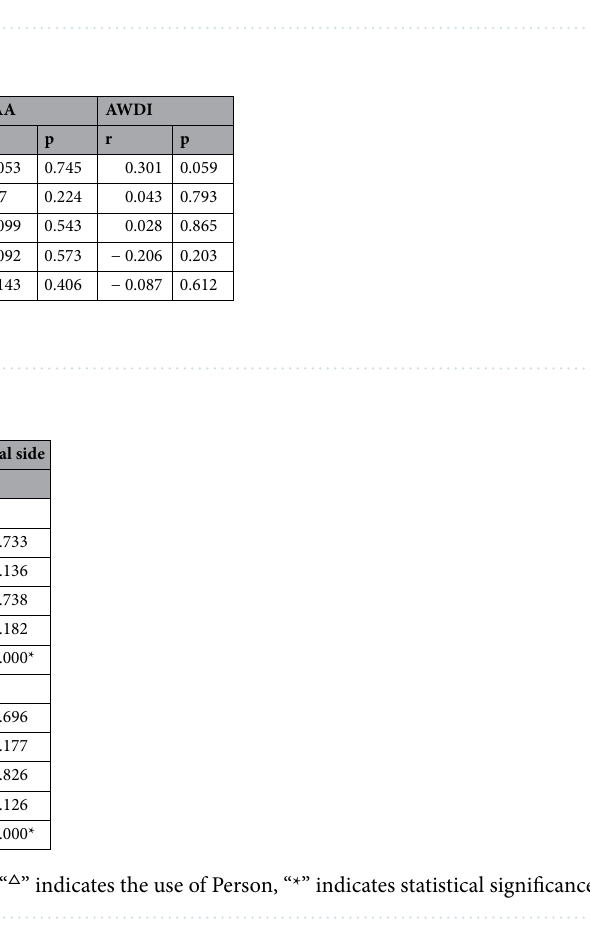
Table 3. Comparison of affected side and contralateral side. “ ▲ ” use paired t test. “ △ ” uses Wilcoxon rank test. “*” indicates statistical significance. Normal data, described by mean ± standard deviation. Non-normal data, described by median (P25, p75).